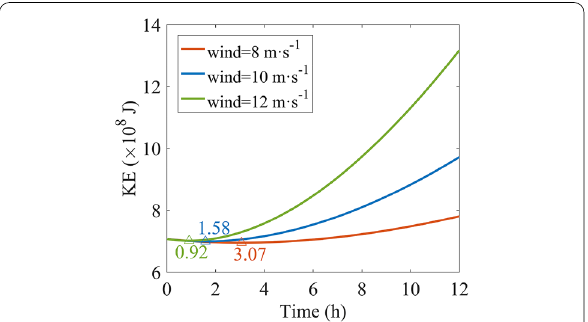
Fig. 4 KE time series of the eddy area integration for wind speed of 8 m · s − 1 (blue), 10 m · s − 1 (red), and 12 m · s − 1 (green). Triangles are the point of minimum KE for each wind speed and is the KE inflection point of